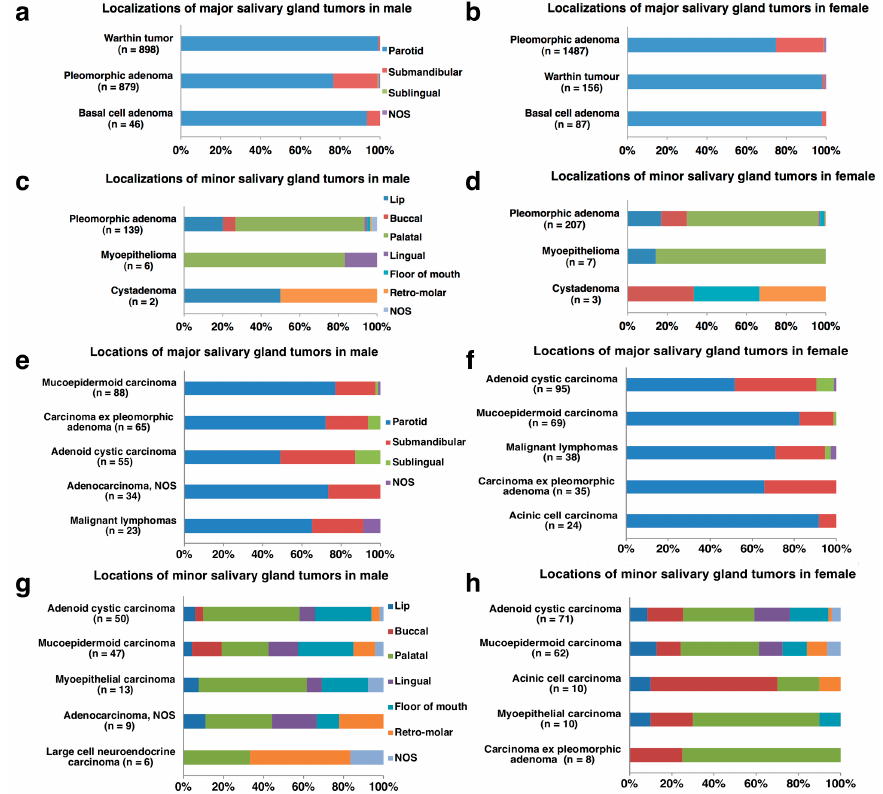
Figure 3. Representative histological frequencies and locations of major and minor salivary gland tumors ( a – h ). ( a – d ) benign salivary gland tumors, ( e – h ) malignant salivary gland; NOS: not otherwise specified. The cases ranged in age from 6 to 97, with a mean age of 54.3 years old and a median age of 57 years old. The peak incidence was in the seventh decade (26%, 660 / 2514) in the males and in